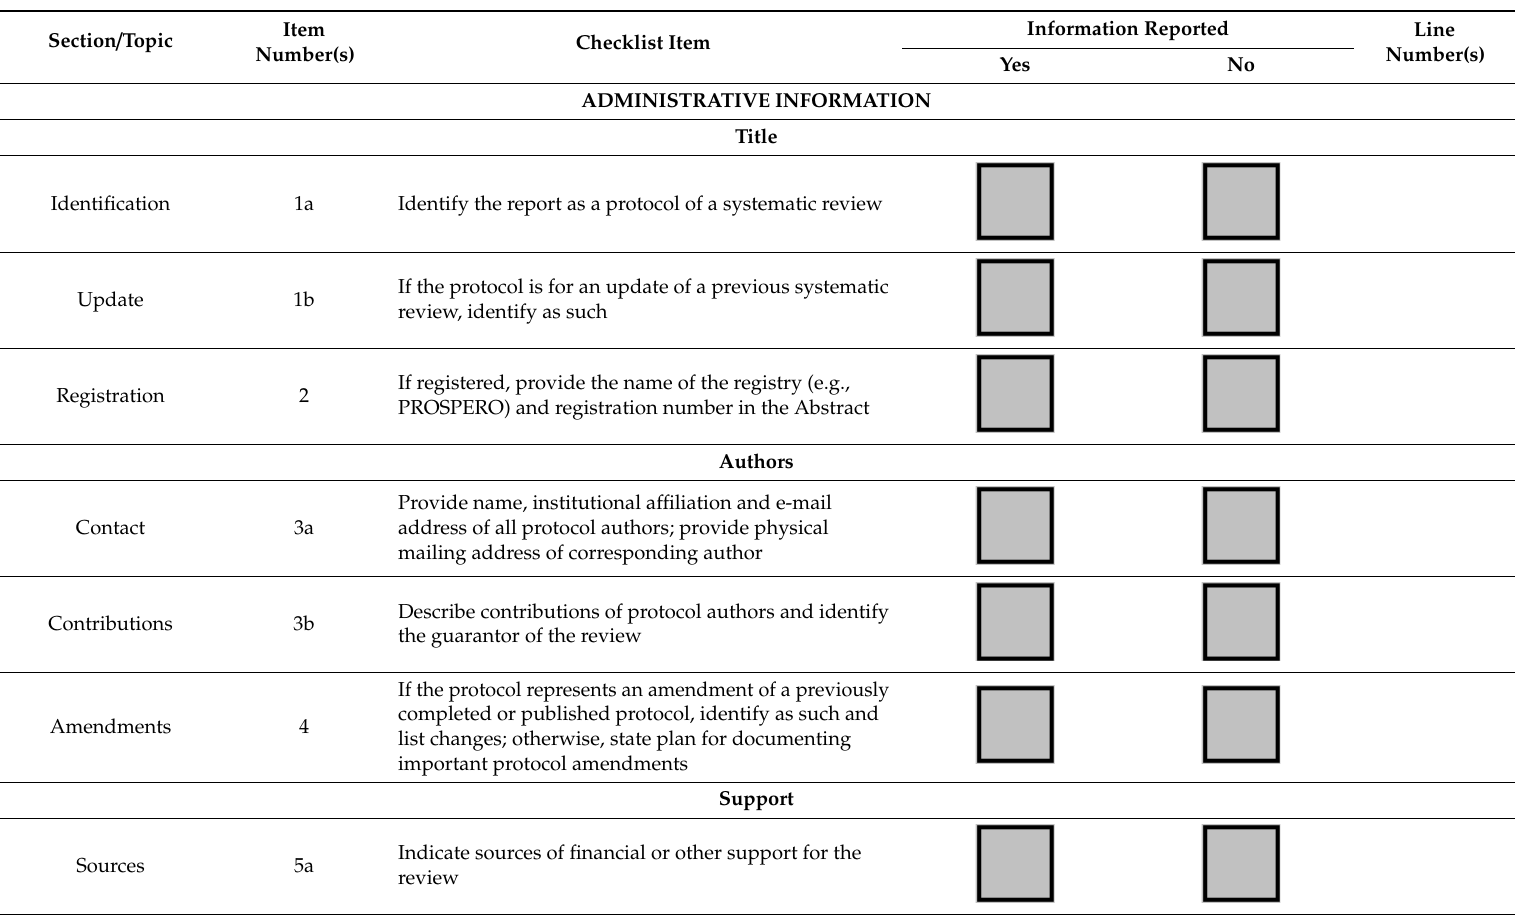
Table A1. PRISMA P Checklist 2015 for Systematic Review Protocols